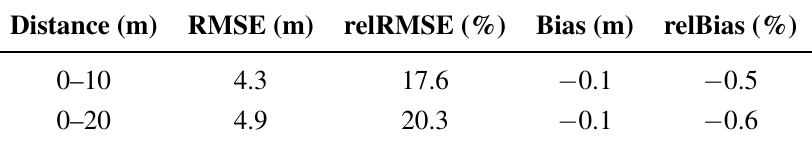
Table 6. Tree height